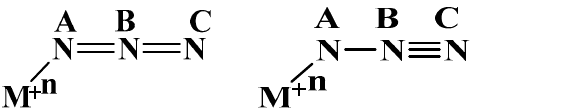
Figure 10. The resonance structures of the terminally coordinated azide. The electron density ( ρ (r)) at the bond critical point was used as a measure for the bond strength. The ρ (r) values of the NA-NB bonds are calculated to be 0.4847 and 0.4833 a.u.